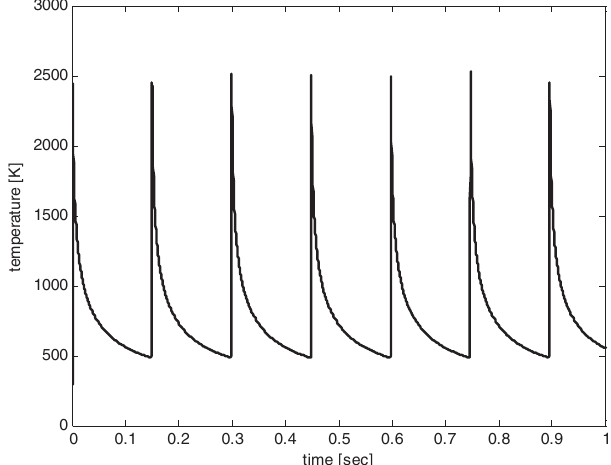
FIG. 1. A temperature field of a BNL linac target in the first second of work at a pulse current of 2 mA.